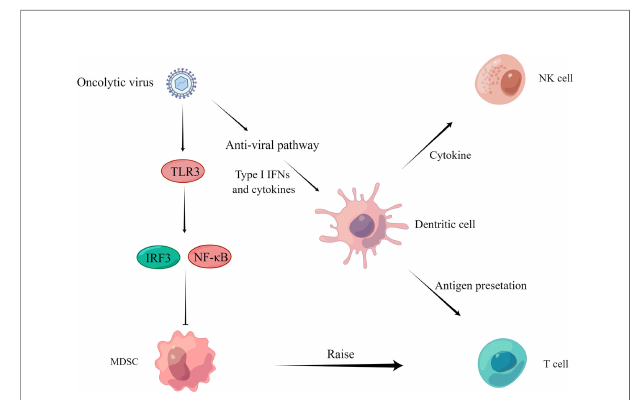
FIGURE 3 | Regulation of anti-tumor immunity. On the one hand, the virus activates IRF3 or NF- k B through the TLR3 pathway and inhibits the proliferation of MDSCs (Katayama et al., 2018) to recruit T cells to play an immune role. On the other hand, the virus activates the anti-viral pathway, induces the production of type I IFN and other cytokines, acts on DCs, NK cells, and T cells through cytokine and antigen presentation, and fi nally activates the body ’ s immune response and kills tumor cells.